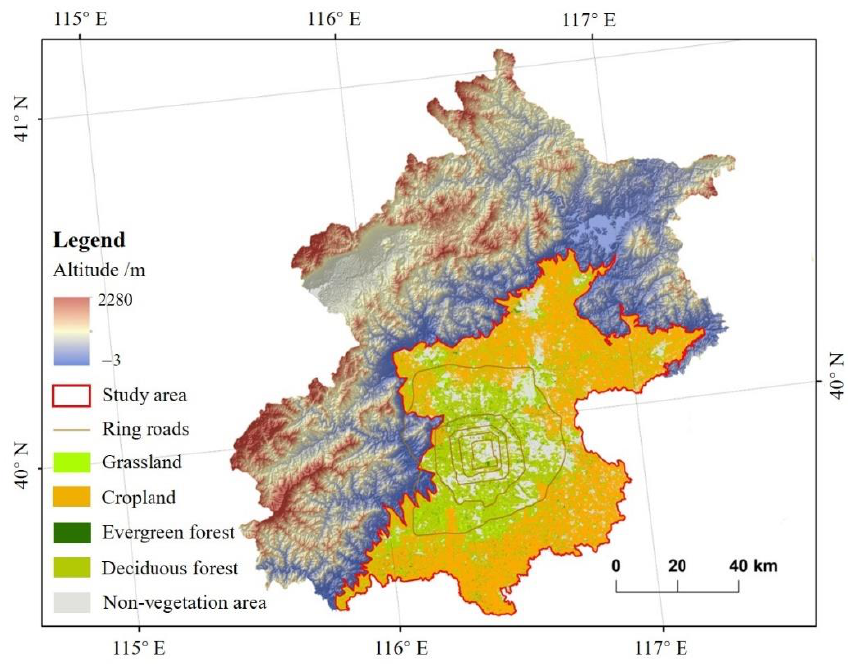
Figure 1. Study area. Note the downtown area of Beijing is mainly located within the Outer Ring Road.